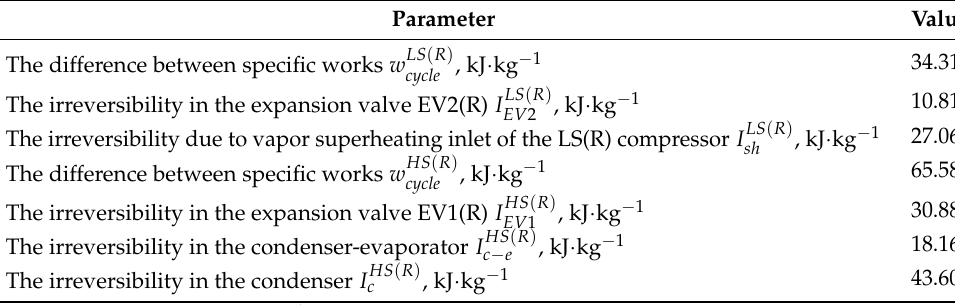
Table 4. The analysis of the topping stage of the cascade